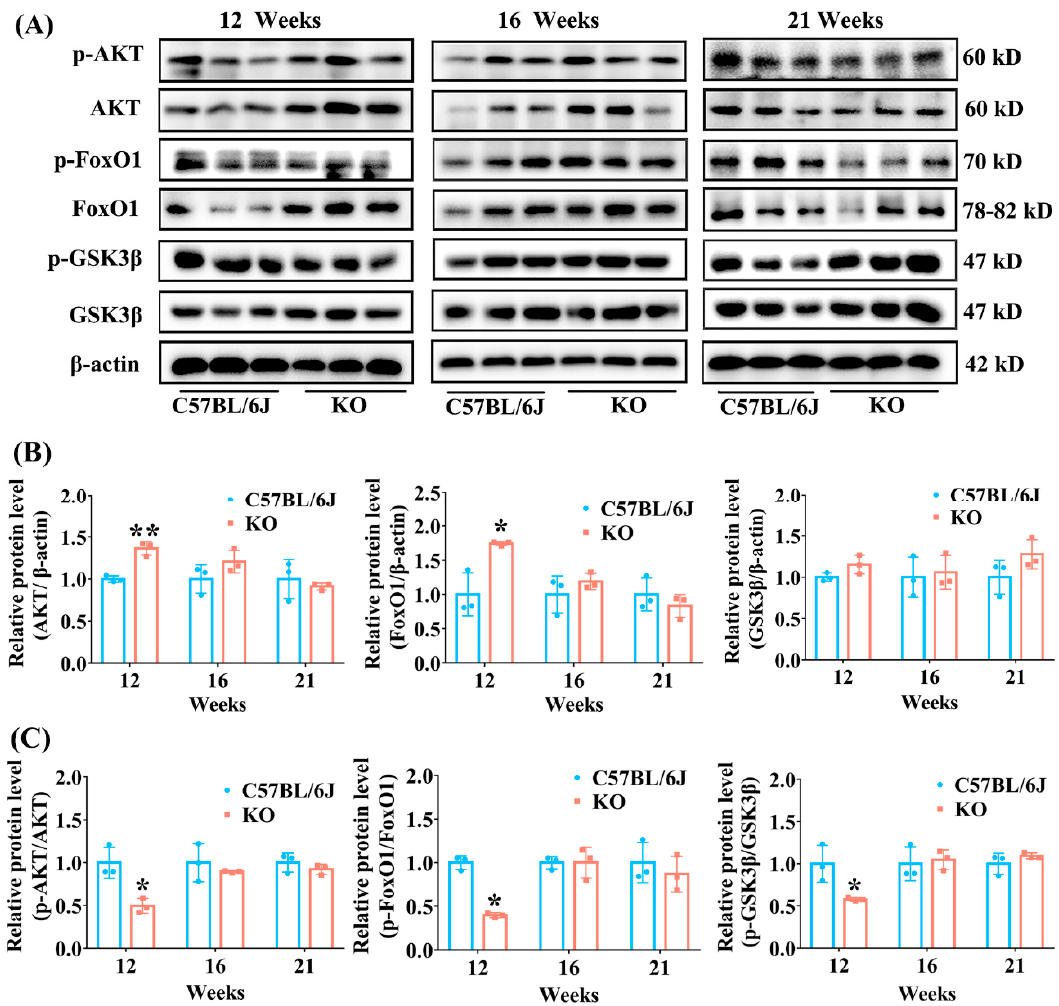
Figure 6. Effect of SELENOF KO on the expression of key proteins involved in insulin signaling pathway in the liver of mice at different ages. ( A ) Representative Western blot bands of phosphorylated AKT (p ‐ AKT), AKT, phosphorylated FoxO1 (p ‐ FoxO1), FoxO1, phosphorylated GSK3 β (p ‐ GSK3 β ) and GSK3 β . ( B ) Semi ‐ quantification analysis of AKT, FoxO1 and GSK3 β normalized to β‐